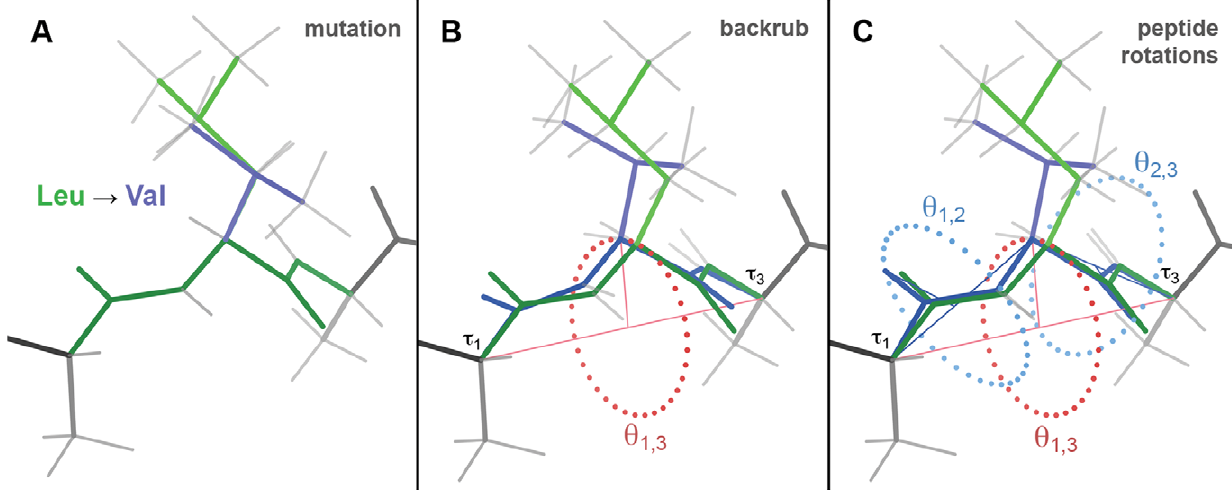
Figure 1. The backrub move for mutation-coupled local protein backbone adjustment. ( A ) A theoretical mutation in ideal b -sheet, from Leu in the mt rotamer (green) to Val in the m rotamer (blue) [43], changes the interactions of the sidechain with its surroundings. Hydrogen atoms are shown in gray. ( B ) The primary backrub rotation angle h 1,3 (red dotted circle) rotates the dipeptide of interest around the C a 1 –C a 3 axis (red line). As a result, the sidechain of residue 2 (the central residue) swings in a hinge-like manner. In the theoretical example shown, the space occupied by the new Val sidechain is now more similar to the space originally occupied by the Leu sidechain. ( C ) The secondary peptide rotation angles h 1,2 and h 2,3 (blue dotted circles) counter-rotate the individual peptides around the C a 1 –C a 2 and C a 2 –C a 3 axes (blue lines) to alleviate any strain introduced into the flanking t 1 and t 3 bond angles, respectively, and to restore H-bonding of the two peptides’ amides and carbonyls, if necessary. The rotation angles, including the primary backrub angle h 1,3 , define a motion, not a structure, and thus are meaningful only in reference to a pair of conformations (e.g. before vs. after or mutant vs.